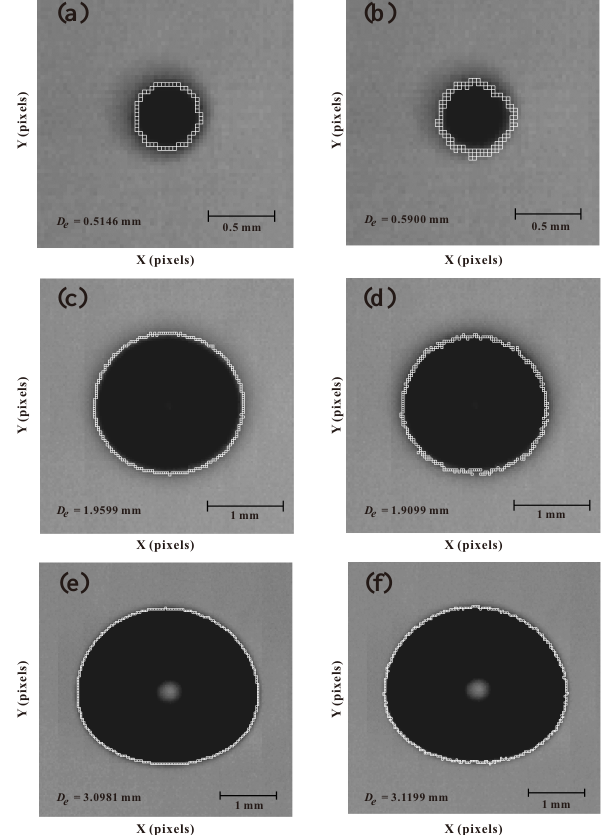
Figure 4. Drop outlines for three different sizes of water drops (small, medium, and large) determined objectively by the difference in brightness value between the drop image and its background im- age (a, c, e) and by the gradient of brightness along the radial direc- tion from the drop center (b, d, f) . Equivalent diameter of the drop ( D e ) derived from the determined drop outline is also indicated in each